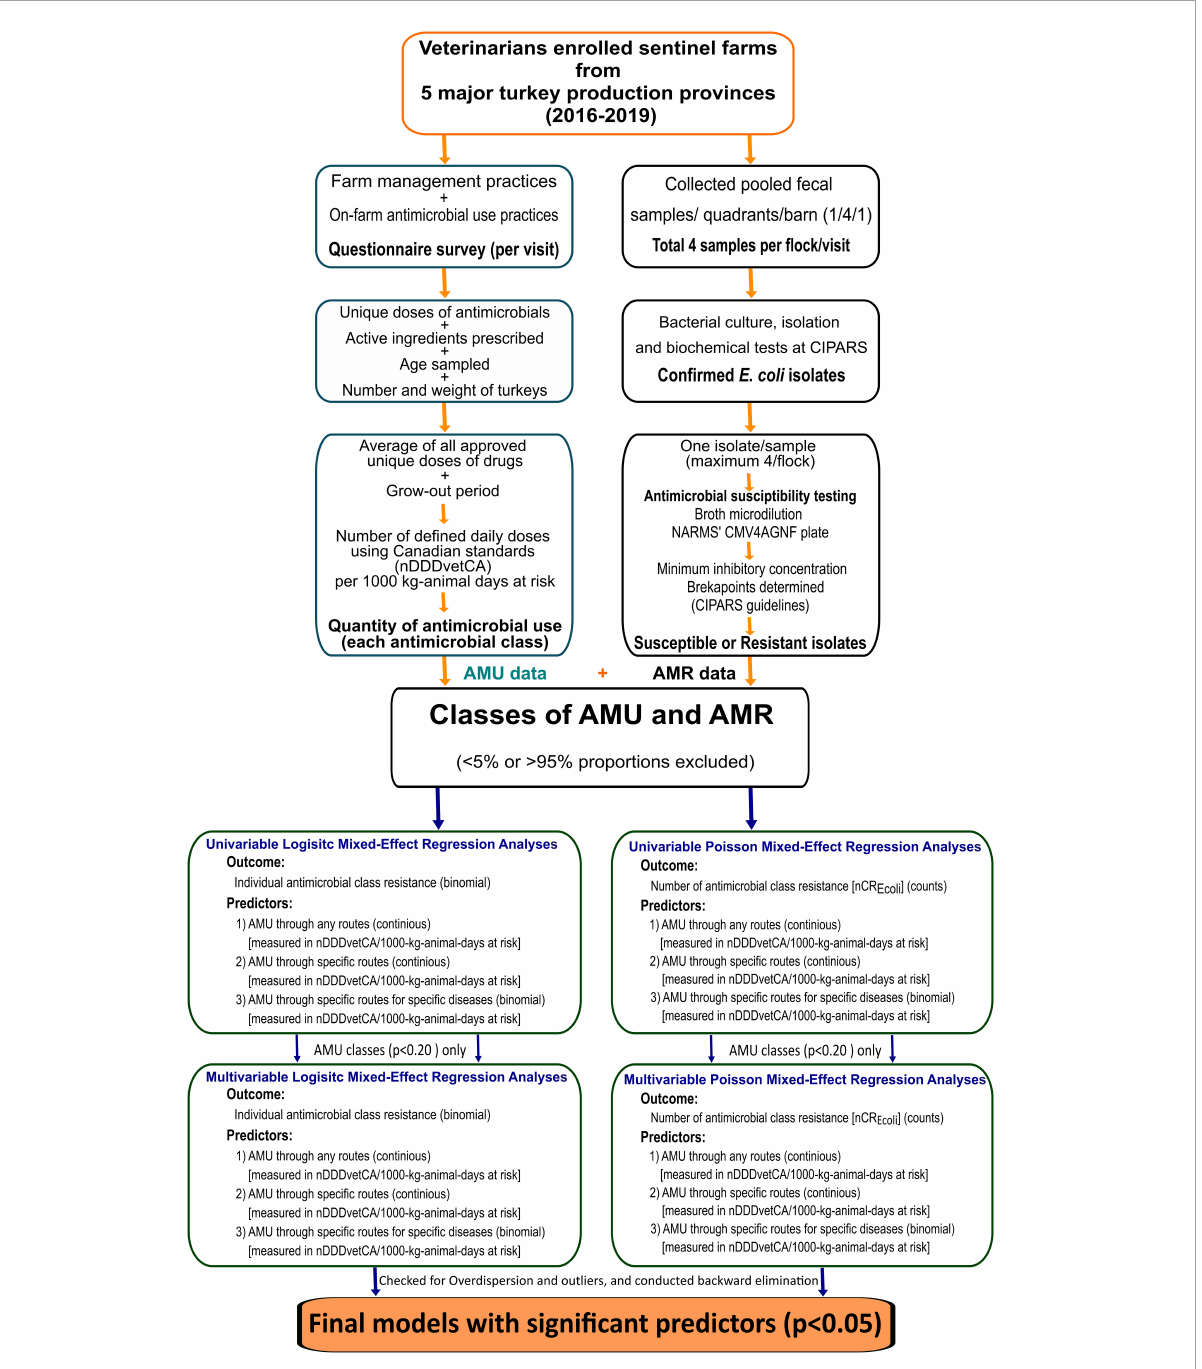
FIGURE1 Summary of surveillance design, laboratory, and statistical analysis methods. AMU, antimicrobial use; AMR, antimicrobial resistance; nCR E . coli , number of antimicrobial classes to which an E. coli isolate was resistant; nDDDvetCA, number of defined daily doses in animals using Canadian